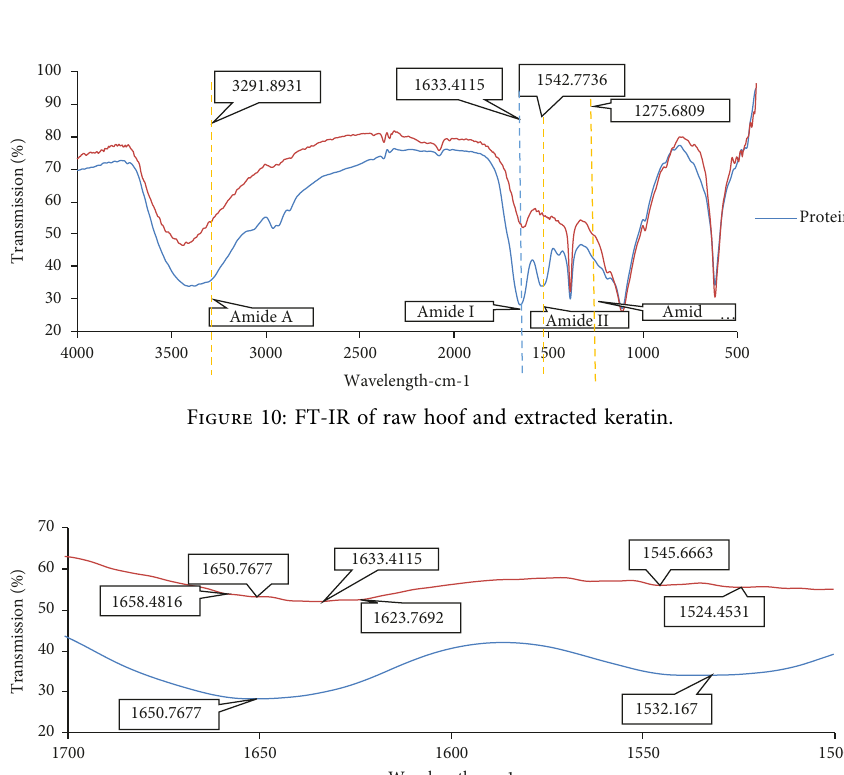
Figure 9: Biuret test for the extracted solutions.